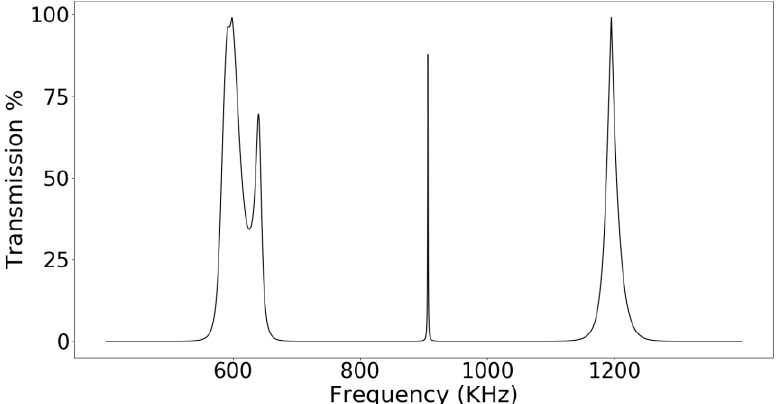
Figure 3. Simulated frequency response of the phononic crystal sensor.